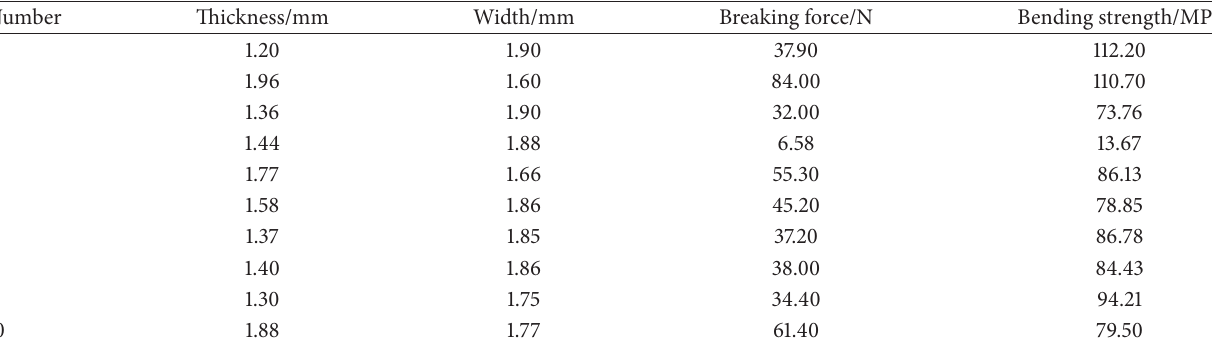
Table 1: Exact dimensions, breaking force, and bending strength of the untreated control (group 1). The mean value of the bending strength is 82.02 MPa with a standard deviation of 27.25